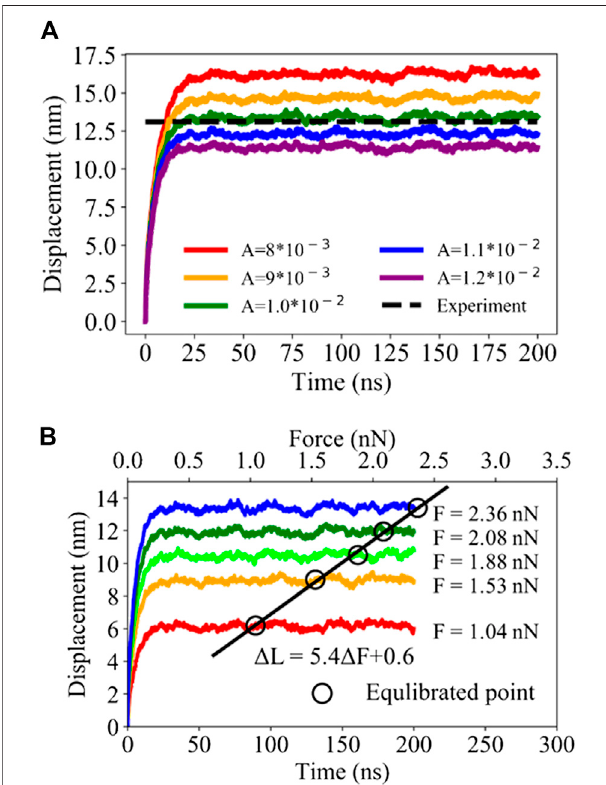
FIGURE 6 | (A) The relationship of the terminal displacements of microtubule models with the different values used for the parameter A in the units of kg − 1 s − 1 . The black dashed line represents the experimental displacement and the colorful curves denote the displacements of microtubule models changing with time under an external force of 2360 pN in force-clamp MD simulations. (B) The curves of the displacements of microtubule models under the different forces ranging from 1.04 to 2.36 nN, where the black hollow circles denote the average values of the end-to-end displacements sampled from 100 – 200 ns. The black line denotes the linear fi tting of the circles.